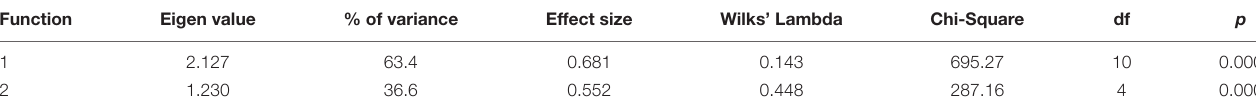
TABLE 3 | Discriminant Functions.